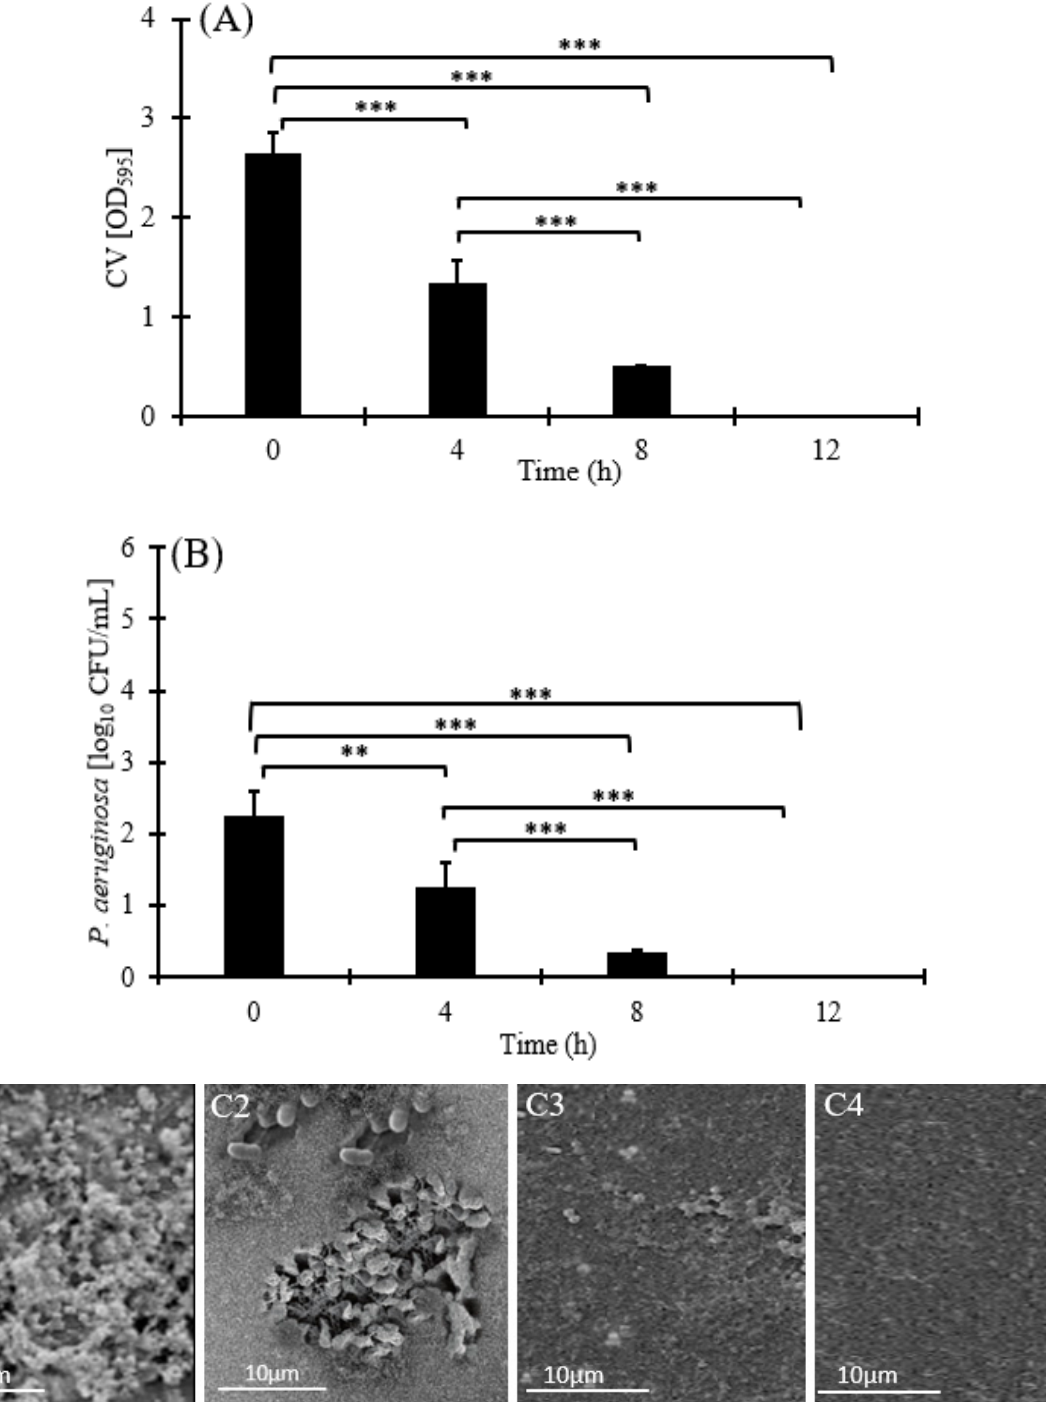
Figure 8. ( A ) Anti-biofilm activity of vB_PseuP-SA22 on biofilms of CRPA at an MOI of 0.1. ( B ) Viable bacterial cell counts at different ages of biofilm at an MOI of 0.1. All values designate mean ± SD of triplicate experiments. Two-way ANOVA and the Bonferroni post-hoc test were carried out using the GraphPad Prism software. Significant differences are illustrated using asterisks ( p < 0.05; **, p < 0.01; *** , p < 0.001); and ( C1 – C4 ) Scanning electron microscopic images showing the biofilm at different time intervals ( C1 , 0 h; C2 , 4 h; C3 , 8 h; C4 , 12 h). Scale bar = 10 µm at a magnification of 5000×.